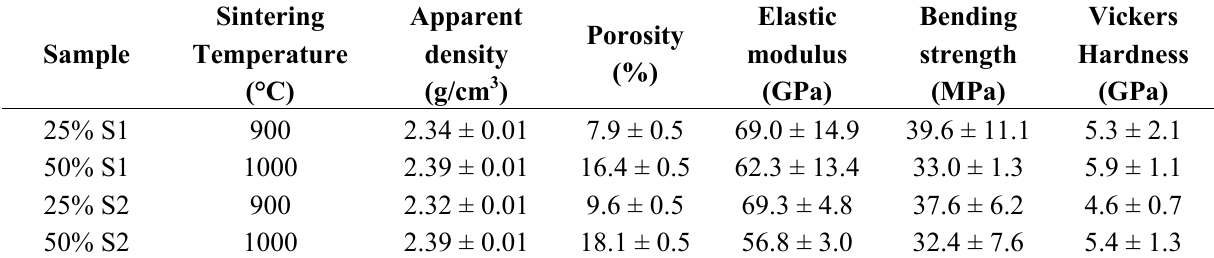
Table 2. Physical and mechanical properties of selected glass ceramics based on glass/slag